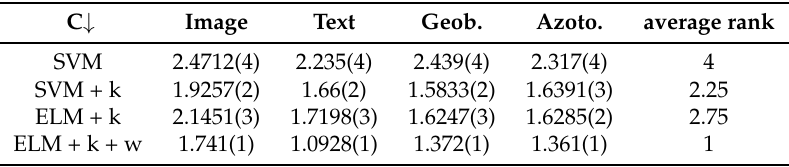
Table 10. Friedman test of the gradual effectiveness evaluation on criterion C .